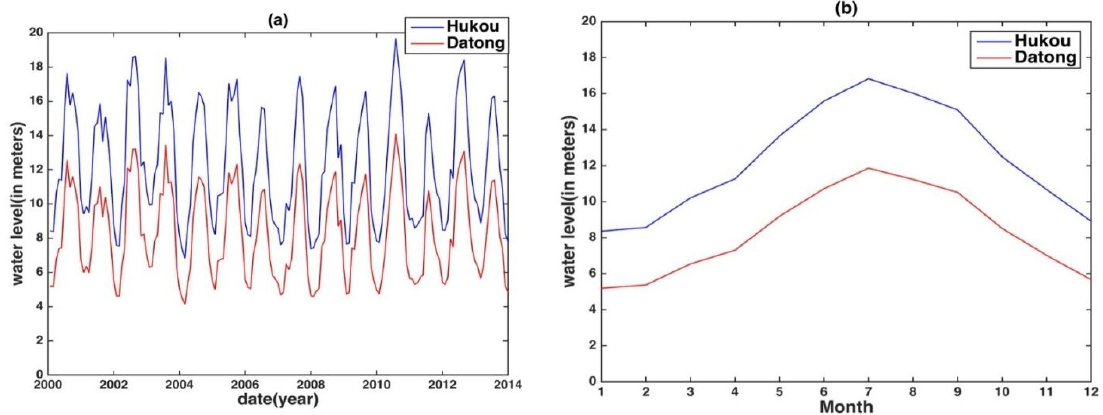
Figure 2. Monthly-averaged water level time series ( a ) and mean monthly-averaged water level ( b ) at Hukou (blue) and Datong (red) stations originating from daily water level data.